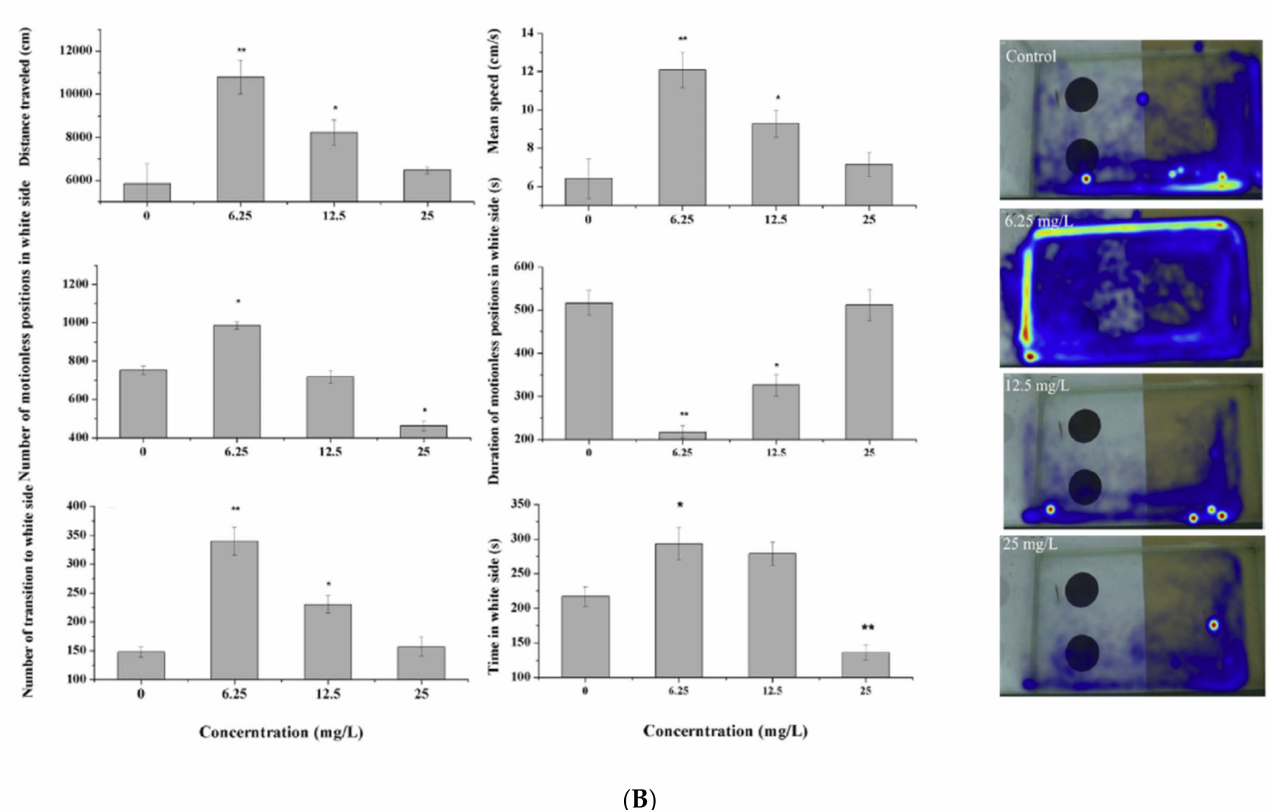
Figure 2. Basic behavioral endpoints of the control and DKA exposed groups (6.25, 12.5 and 25 mg/L) obtained from bottom swelling ( A ) and conditioned place preference ( B ) tests. The video trials resulting from the behavioral tests were reused in Ethovision XT software (Noldus IT, Wageningen, Netherlands) to generate average heat maps for experiments. Data represent average ± SD ( n = 33–36 individuals for bottom swelling test and n = 34–36 individuals for CPP test) evaluated by one way ANOVA (* p < 0.05 and ** p < 0.01)